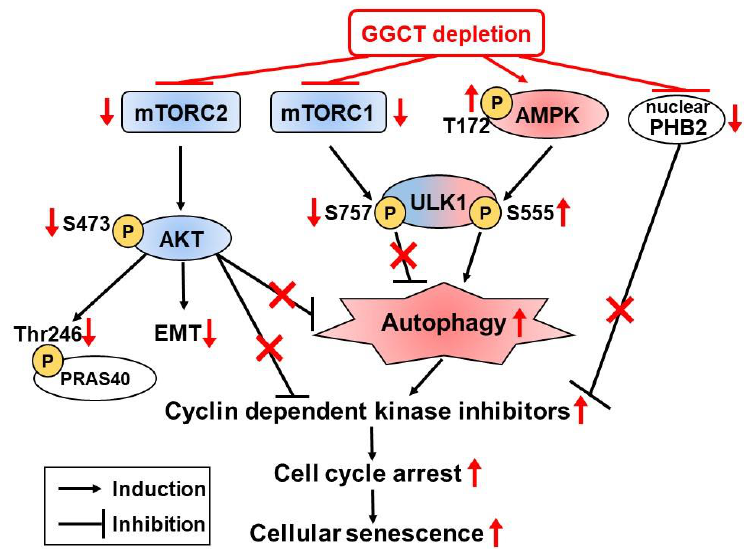
Figure 2. Hypothetical mechanisms of tumor growth inhibition by depletion of GGCT. Promoting effects are illustrated with black arrows, inhibiting effects are illustrated with black T, and the influences by GGCT knockdown are indicated in